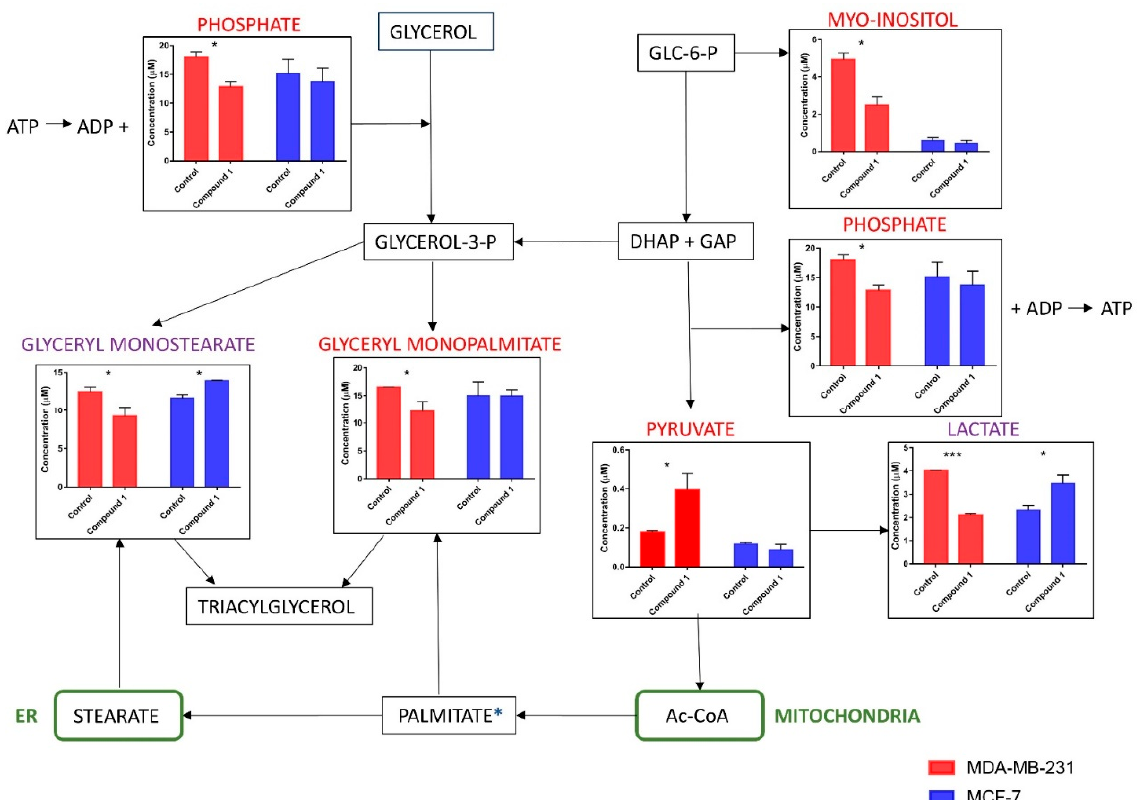
Figure 9. The relative concentrations of the metabolites. Notes: The relative concentrations of the metabolites involved in the glycolytic pathway and triacylglycerol pathway (part) in MDA-MB-231 cells (red) and MCF-7 cells (blue) after treatment with compound 1 in duration of 48 h. Data are expressed as the mean value ± SD of three independent experiments. Columns, mean of cells; bars, SD; * p < 0.05; *** p < 0.001; SD, standard deviation; purple text indicates metabolites concentrations changed after treatment in both cell lines; ER, endoplasmatic reticulum; ADP, adenosine diphosphate; ATP, adenosine triphosphate; GLC-6-P, glucose-6-phosphate; glycerol-3-P, glycerol-3-phosphate; DHAP, dihydroxyacetone phosphate; GAP, glyceraldehyde 3-phosphate; Ac-CoA, acetyl-coenzyme A.